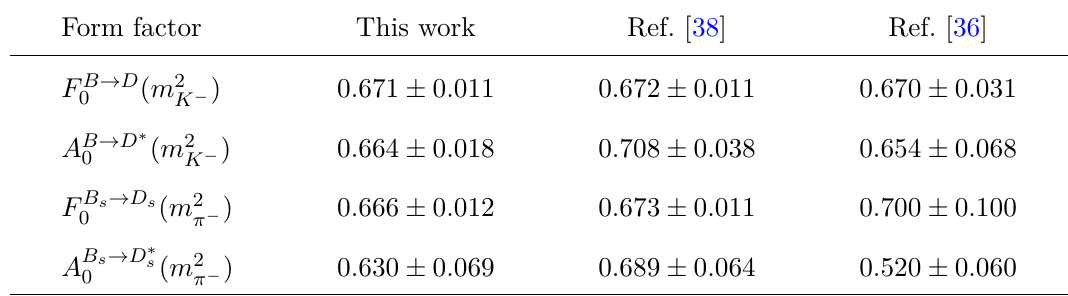
Table 2 . Numerical results for some of the B q 2 = m 2 or q 2 = m 2 , together with the ones used in refs. [36, 38]. K − π −